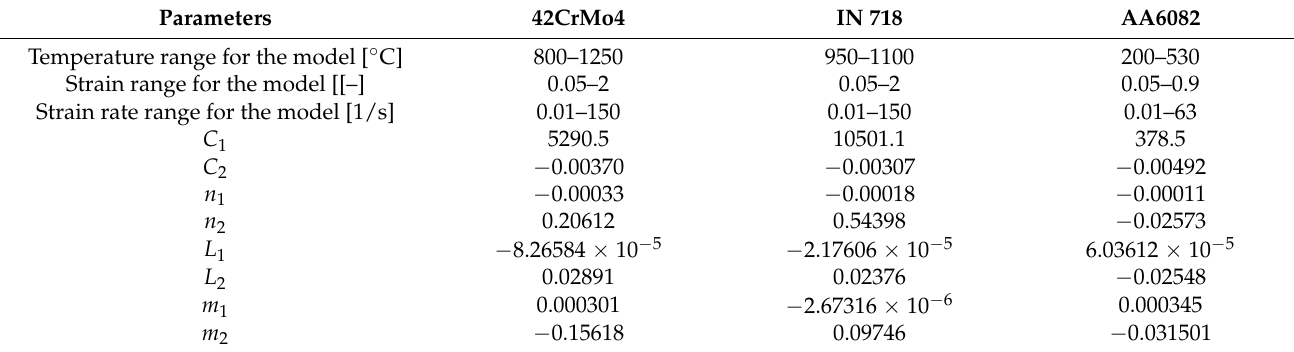
Table 3. Validity range and Hansel-Spittel flow stress model constants for the (i) 42CrMo4 steel, (ii) Inconel 718 super alloy and (iii) AA6082 (AlMgSi) aluminum